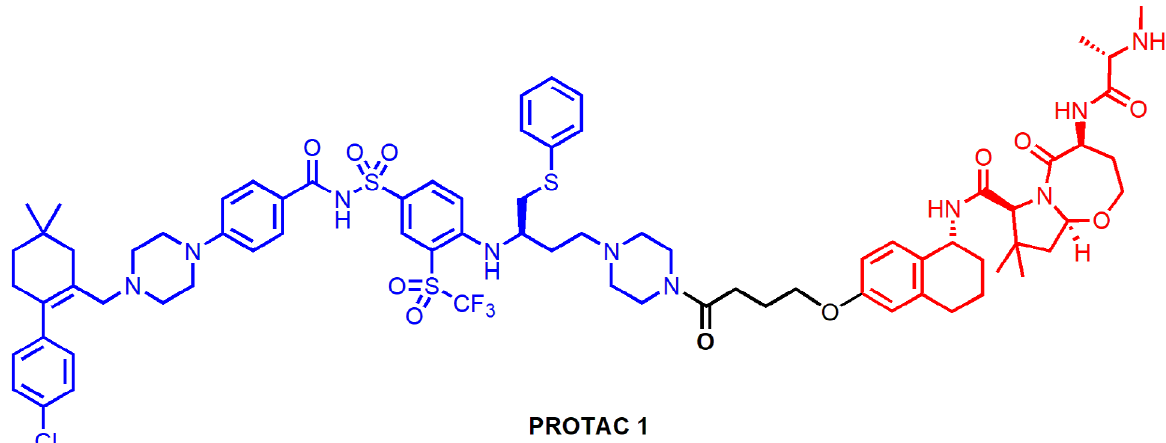
Figure 7. Chemical structure of PROTAC 1 that recruits IAPs for BCL-X